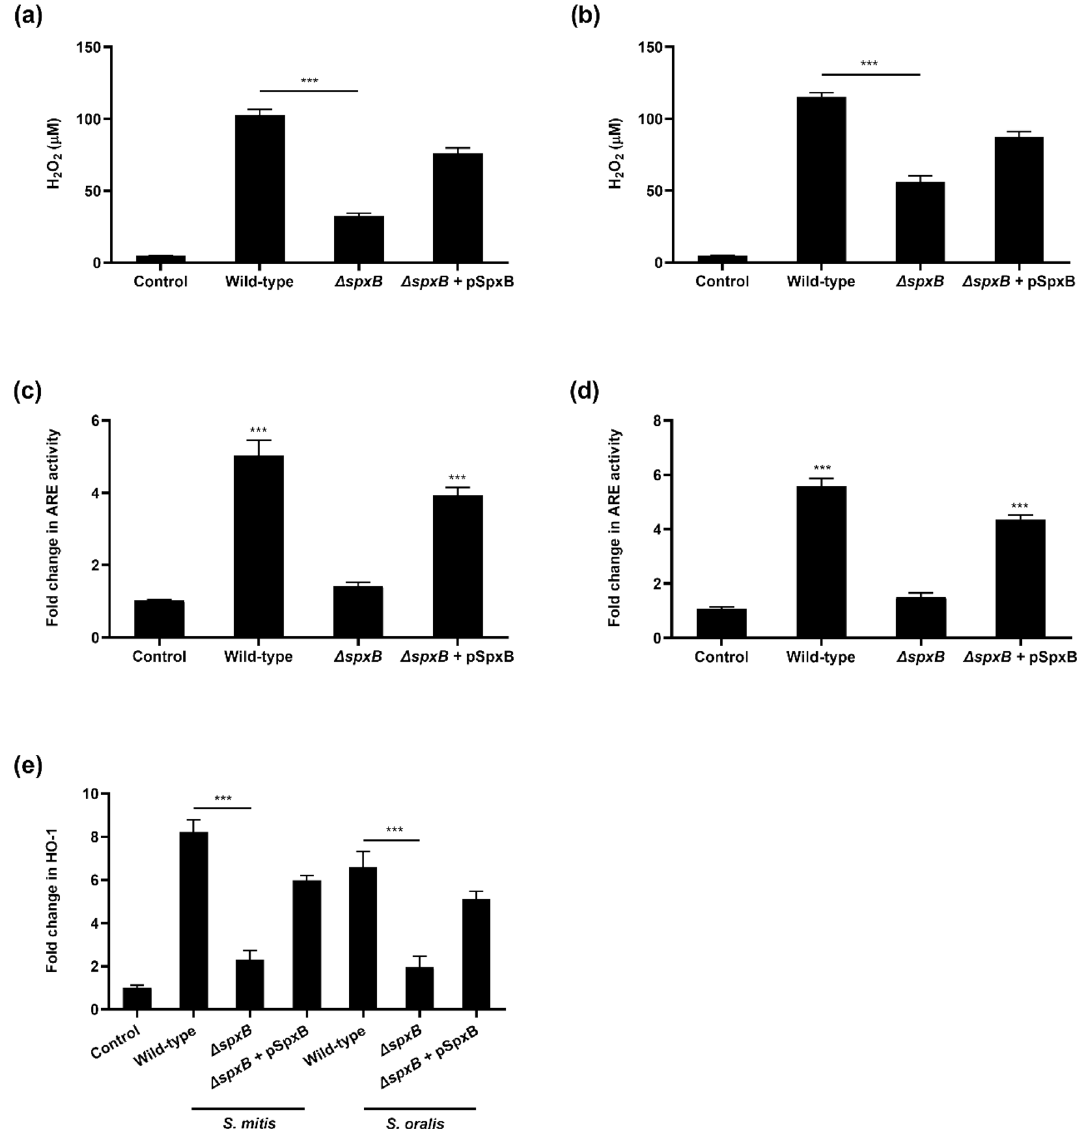
Figure 3. Bacterial SpxB mediated the activation of Nrf2-ARE. The amount of H 2 O 2 produced by wild- type, ΔspxB mutants and ΔspxB complemented mutant ( ΔspxB + pSpxB) of ( a ) S. mitis and ( b ) S. oralis were measured. Raw 264.7 cells stably expressing the Nrf2-ARE SEAP reporter were infected with wild-type, ΔspxB mutants or ΔspxB complemented mutants of ( c ) S. mitis or ( d ) S. oralis . Cellular ARE activity was quantified by SEAP reporter assay. The expression of ( e ) HO-1 was determined by qRT-PCR. ***p < 0.001 compared to the control